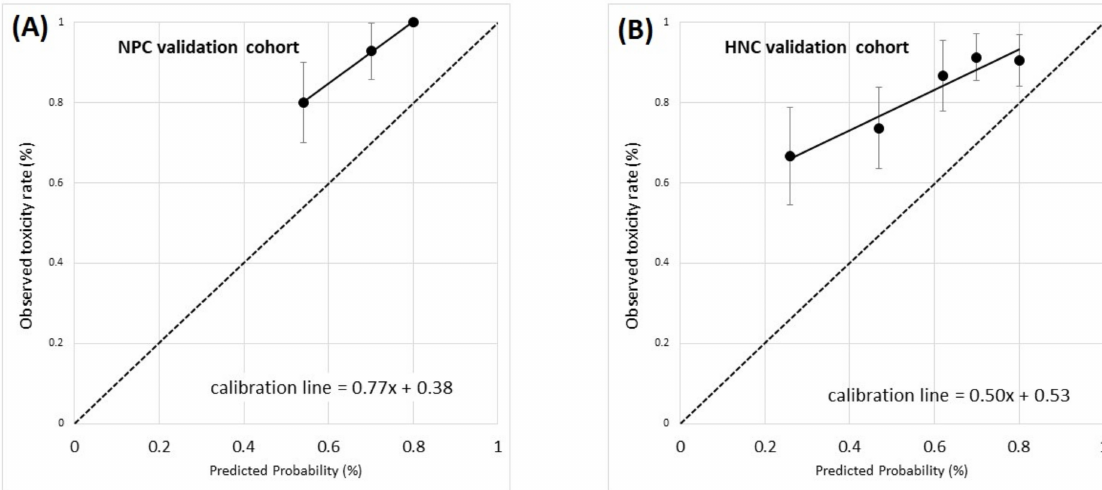
Figure 6. Calibration plots for validation of the model for grade ≥ 2 acute salivary dysfunction in the two independent external cohorts: ( A ) nasopharyngeal cancer (NPC) cohort and ( B ) head and neck cancer other than NPC cohort (HNC). Calibration plots present the rate of observed events in a group of patients ( y -axis) vs. the mean predicted probability for the same group ( x -axis). Groups of patients are ordered for increasing predicted probability. Error bars represent the confidence interval in observed frequencies calculated from proportions in the study population and based on a normal distribution of events. The dotted line is the identity line, identifying perfect calibration, the continuous black line is the calibration line. The calibration slope and calibration-in-the-large are also